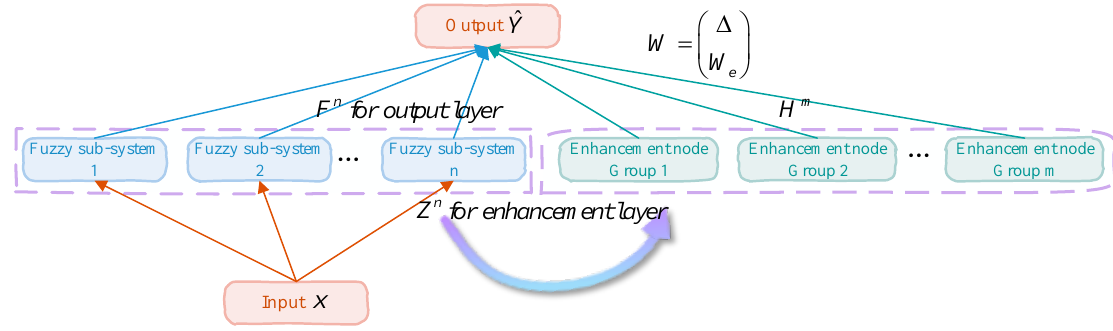
Figure 2. Fuzzy broad learning network structure.